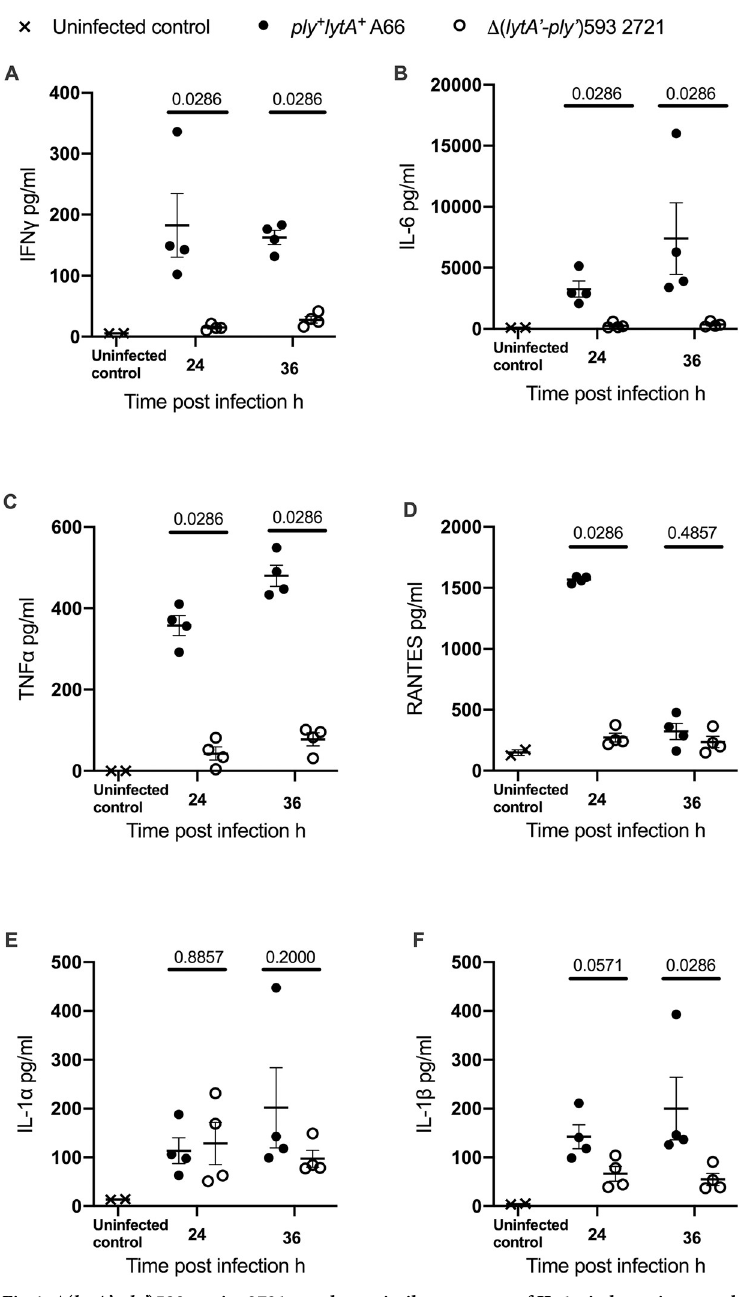
Fig 4. Δ ( lytA’-ply’ )593 strain, 2721, produces similar amounts of IL-1 α in lung tissue to the ply + lytA + strain A66 but induces less IFN- γ , IL-6, TNF α , RANTES, and IL-1 β . Cytokines from lung homogenates of wild type C57Bl/6 mice intranasally inoculated with 8 x 10 � 4 CFU/mouse of ply + lytA + strain A66 or 1.4 x 10 � 5 CFU-mouse of 2721 were measured by a Luminex bead array. Each data point represents one mouse and data were generated from a single experiment. The uninfected control group consists of mice inoculated intranasally with 50 μ l PBS and humanely euthanased at 6 hours. Data analysed with a two-tailed Mann-Whitney test and P values reported. pathology to those seen in an in vivo horse infection model with an equine-associated pneu- mococcal strain [20]. We propose that the loss of autolysin and pneumolysin, specifically in a serotype 3 strain, results in a pneumococcus deficient at both escaping the alveolus, and